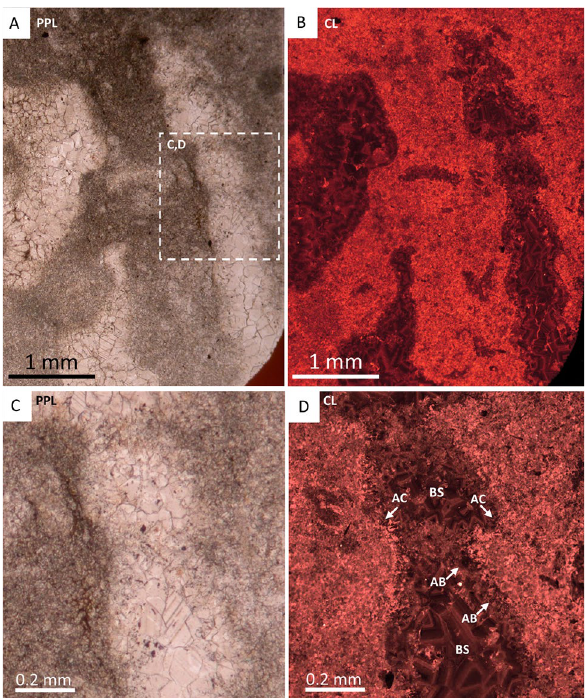
Figure 5. Photomicrographs of cloudinomorphs, probably Cloudina, from Omkyk Farm, Upper Omkyk Member, Nama Group. ( A ) PPL image of cloudinomorph tube. ( B ) CL image of A. ( C ) Inset of A. ( D ) CL image of A, with early acicular cements (AC) which vary between bright and non-luminescence. AC is followed by poorly-zoned acicular bladed calcite (AB). A well zoned blocky calcite (BS) infills the remaining tube cavity. Figure created in PowerPoint